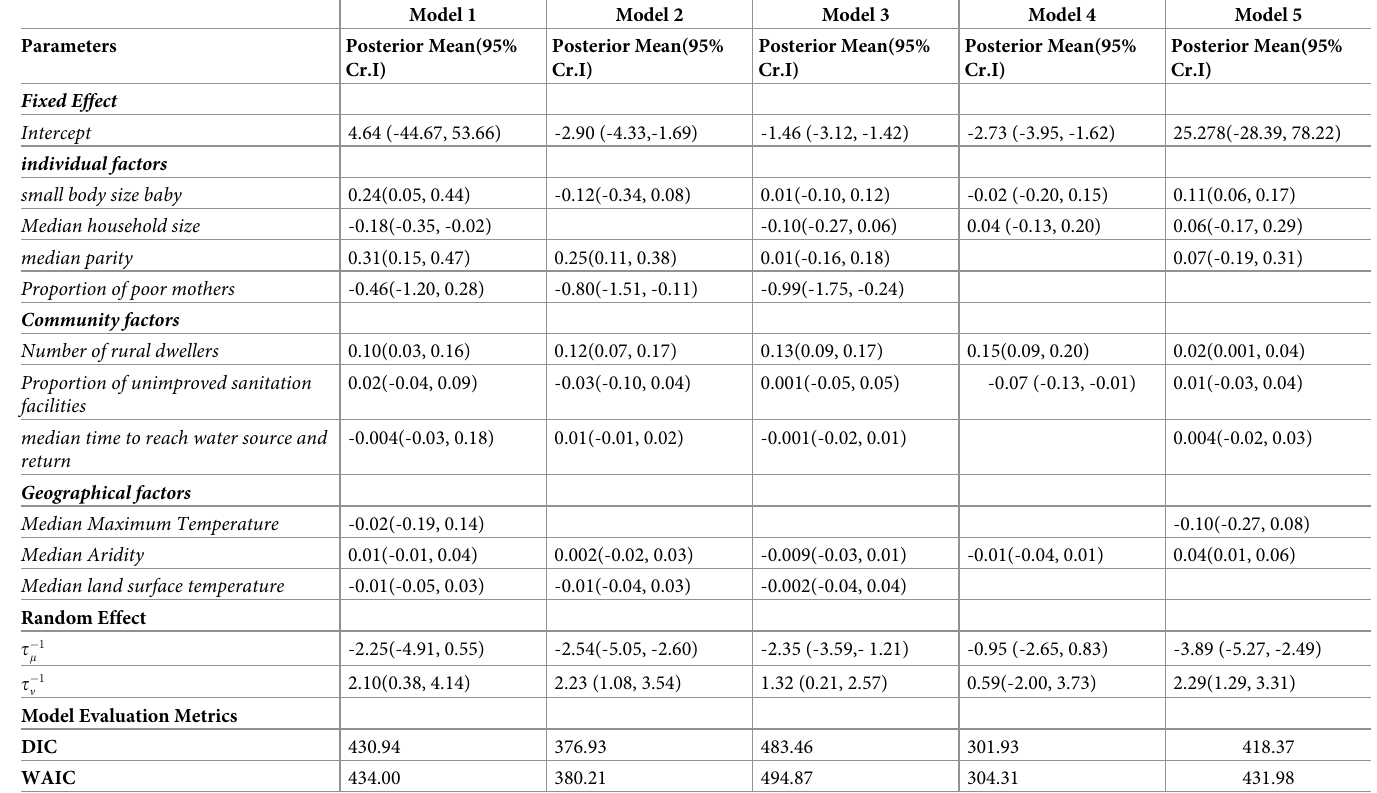
Table 6. Summary of posterior means and Bayesian credible intervals of smooth relative risk of neonatal mortality estimated from weighted Bayesian Hierarchical Spatial model using aggregated Ghana demographic and health survey (GDHS) cluster level